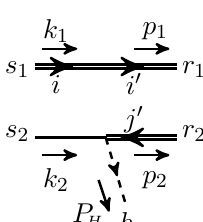
Figure 15 . Example of diagram contributing to the perturbative parts of the amplitudes of various transition processes considered in section